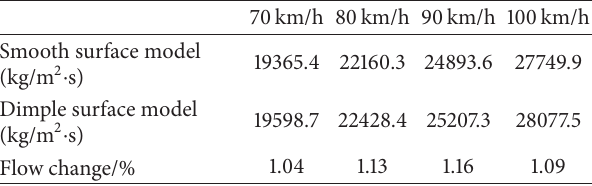
Table 5: Comparison of hydrodynamic pressure at different speeds.